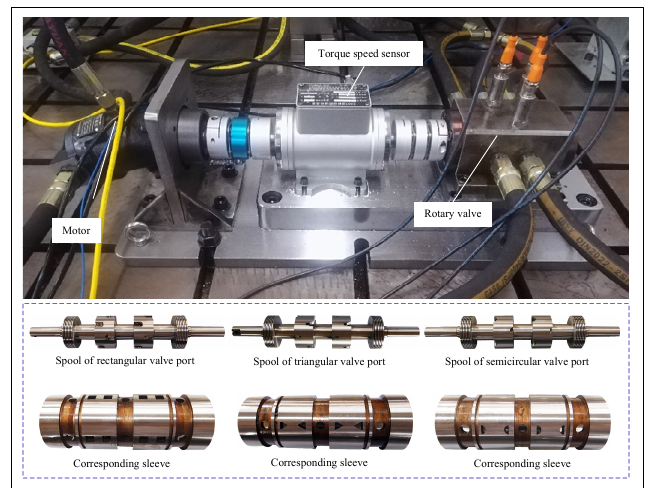
Figure 37. The experimental bench of the hydraulic controlled rotary valve excitation system.